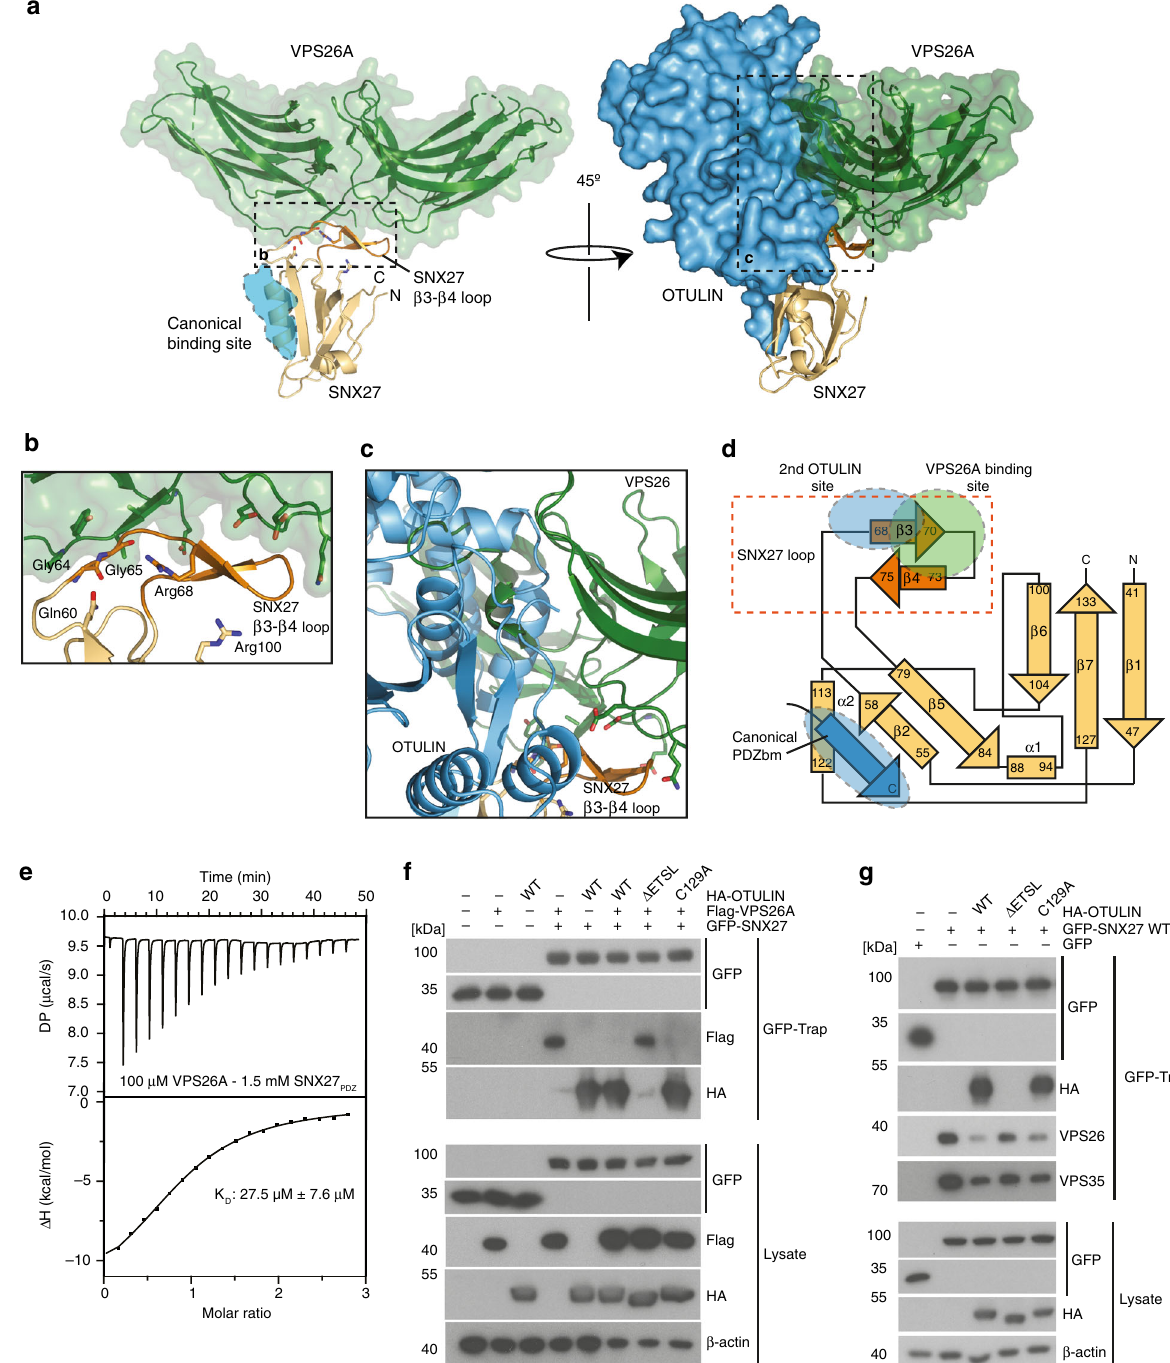
Fig. 5 OTULIN competes with VPS26 for SNX27 binding. a SNX27 utilizes residues from the β 3 – β 4 insertion to engage with the retromer complex. Structure of SNX27 bound to VPS26A (green surface) (PDB: 4P2A). The canonical PDZbm of OTULIN is shown as a blue cartoon. Rotation of the complex by 45° with superimposition of the OTULIN-SNX27 and VPS26A-SNX27 structures onto SNX27. b Close-up view of a , with residues from the SNX27 β 3 – β 4 hairpin that bind to VPS26A shown. c Close-up view of a revealing extensive clashes between OTULIN and VPS26A through overlapping binding sites on the β 3 – β 4 hairpin. d Topology diagram of SNX27 showing the canonical PDZbm binding site and the VPS26A and OTULIN binding sites on the β 3 – β 4 hairpin. e ITC data for SNX27 PDZ domain titrated against VPS26A. f HEK293 cells were co-transfected with GFP-SNX27, Flag-VPS26A, and HA-OTULIN constructs as indicated. GFP-SNX27 was precipitated using GFP-Traps and tested for simultaneous interactions with VPS26A and OTULIN by WB. g HEK293 cells were co-transfected with GFP-SNX27 and HA-OTULIN constructs as indicated. Following GFP-Trap precipitation, binding of GFP-SNX27 to HA-OTULIN and effects on interaction of GFP-SNX27 with the endogenous retromer subunits VPS26 and VPS35 were monitored by WB. Source data are provided as a Source Data fi